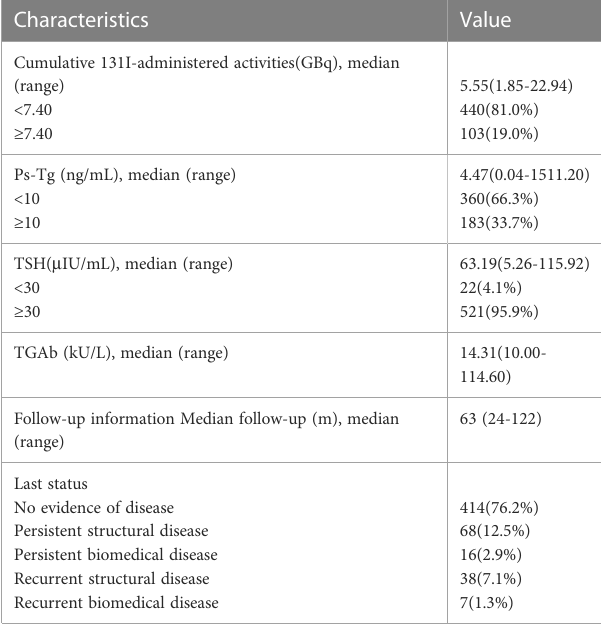
Metastasis stage Generally, long-term remission was obtained in 414 patients (76.2%). In total 129 patients (23.8%) had poor prognosis, 106 patients (19.6%) had a structural incomplete response, and 23 patients (4.2%) had a biochemical incomplete response. Twenty- one patients with positive cytology/histology underwent repeated surgery, 7 patients (33.3%) had a signi fi cant effect, 6 patients (28.6%) changed from structural incomplete response to biochemical incomplete response, 7 patients (33.3%) maintained structural incomplete response, and 1 patient (4.8%) had distant metastases. There were no death associated with DTC during study.